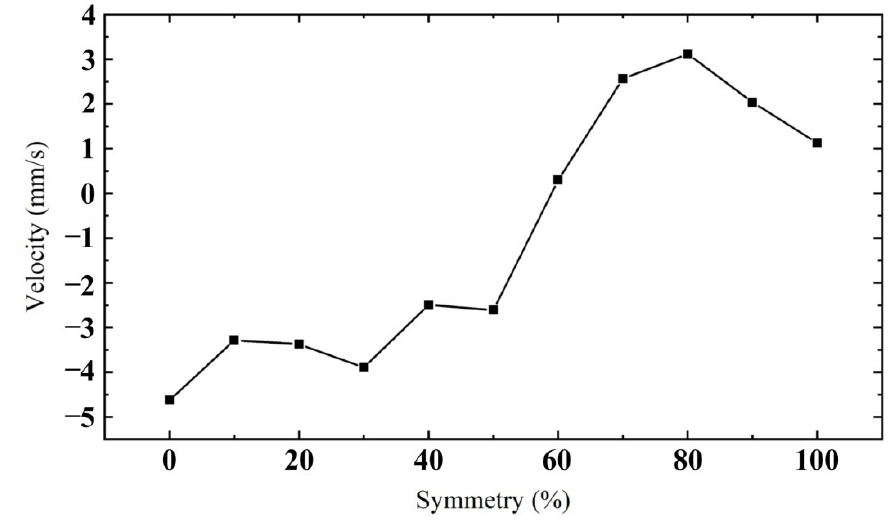
Figure 24. Relationship between mover velocity and oblique wave symmetry.